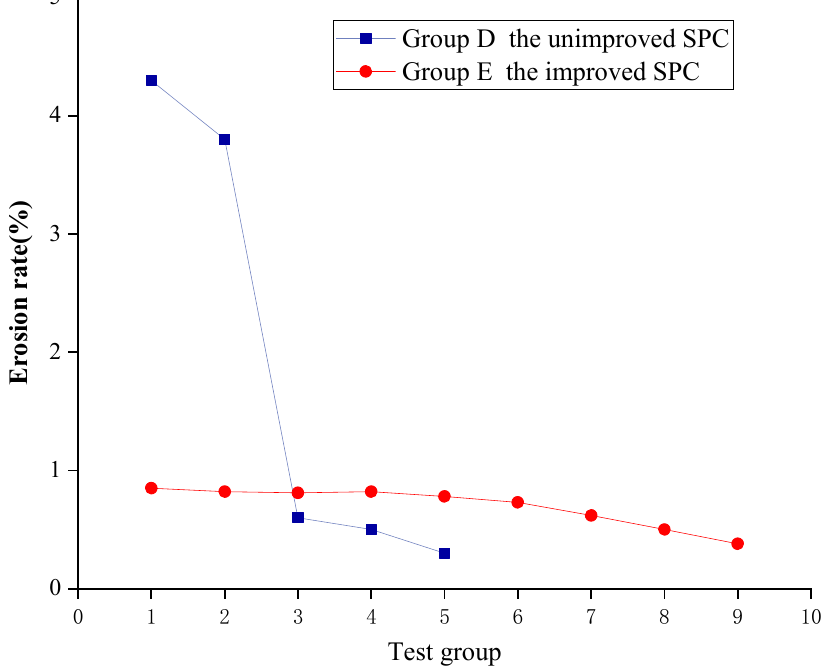
Figure 9. Erosion rates when using SPC before and after improvement.